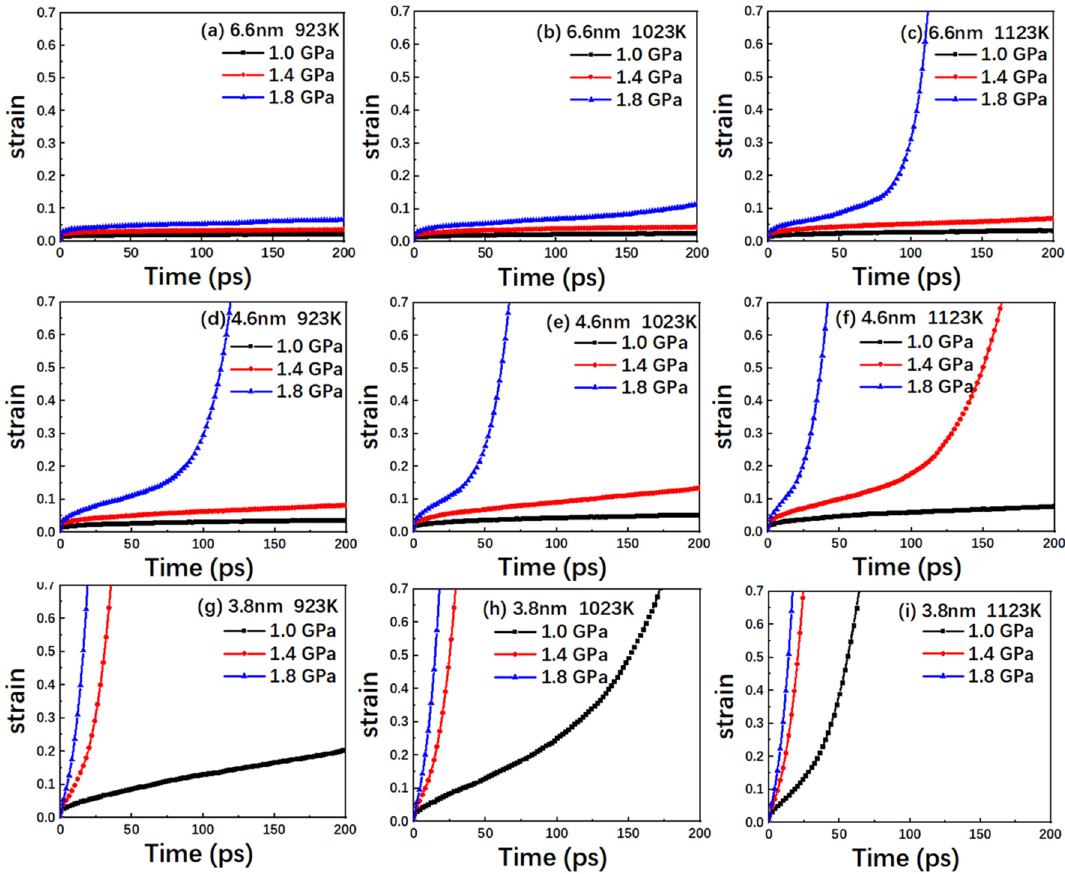
Figure 2. Time versus creep strain curves for the nanocrystalline TiAl models with grain sizes of ( a ) 6.6 nm at 923 K; ( b ) 6.6 nm at 1023 K; ( c ) 6.6 nm at 1123 K; ( d ) 4.6 nm at 923 K; ( e ) 4.6 nm at 1023 K; ( f ) 4.6 nm at 1123 K; ( g ) 3.8 nm at 923 K; ( h ) 3.8 nm at 1023 K; and ( i ) 3.8 nm at 1123 K under the stress levels of 1.0, 1.4 and 1.8 GPa.